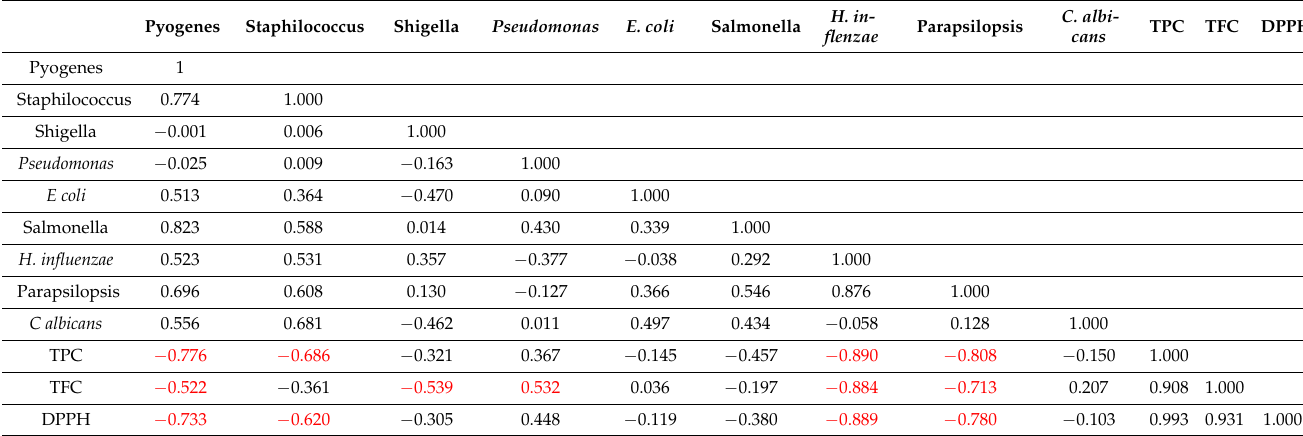
Table 3. Pearson correlation coefficient matrix for ATCC antimicrobial and antioxidant activity of honey samples.